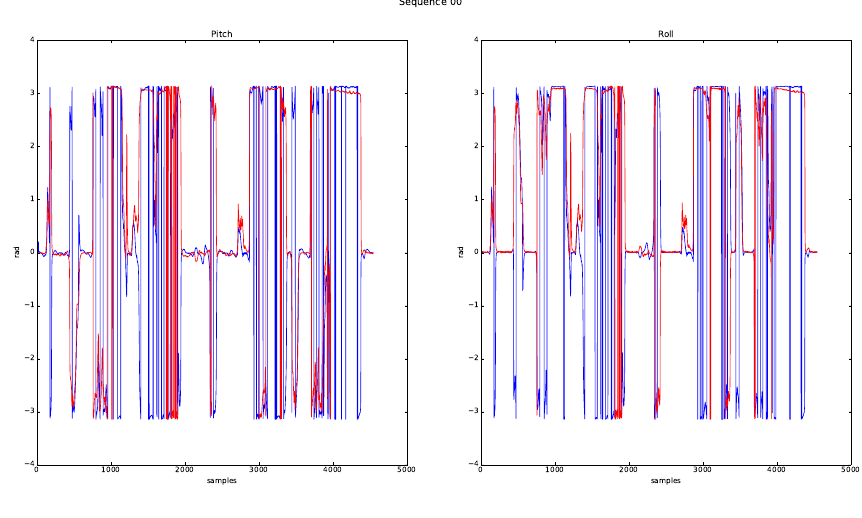
Figure 21. Pitch and roll results for sequence 00.